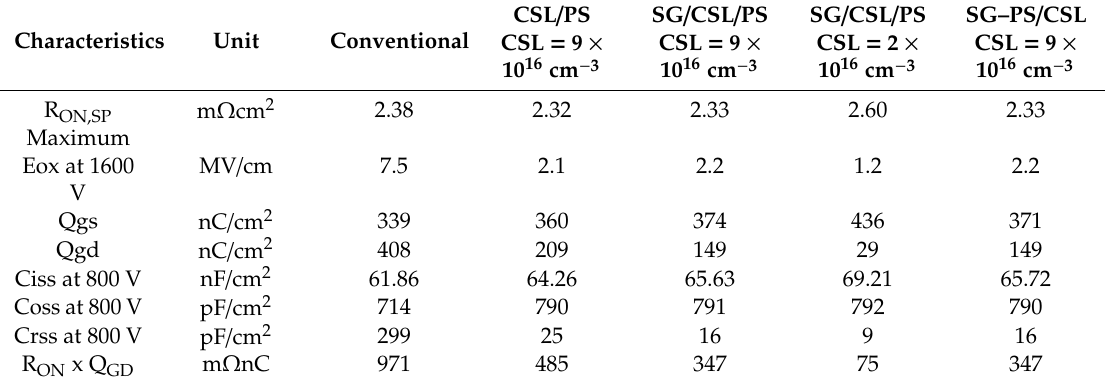
Table 1. Key performance indexes of the gate structures studied in this paper.